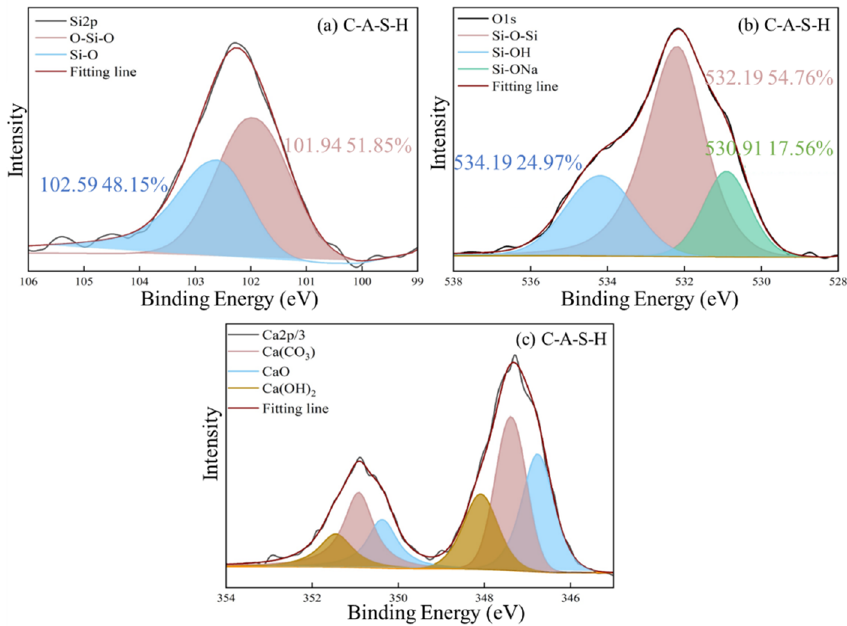
Figure 12. The XPS deconvolution spectrum of ( a ) Si 2p, ( b ) O1s, ( c ) Ca 2p/3 of reference C-A-S-H.